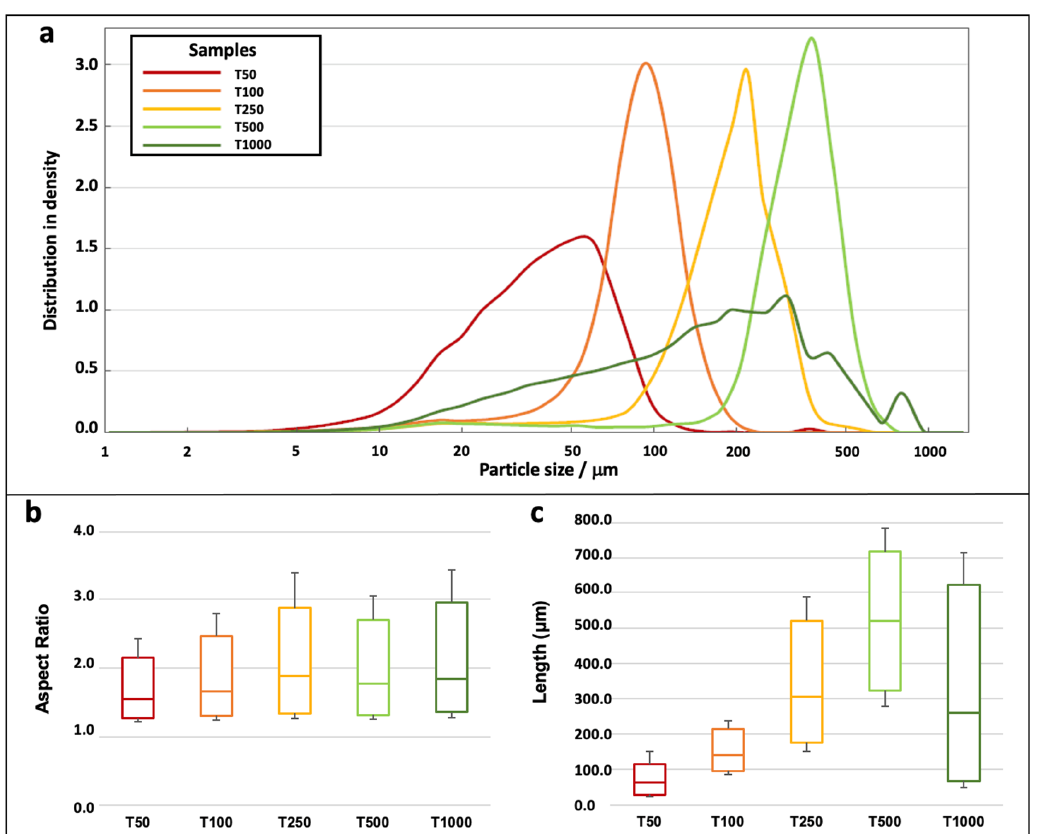
Figure 1. SEM observations of tomato biomass particles at different magnifications. For 25×, 100×, and 500× magnification, the white scale bar corresponds to 500, 100, and 50 mm, respectively.